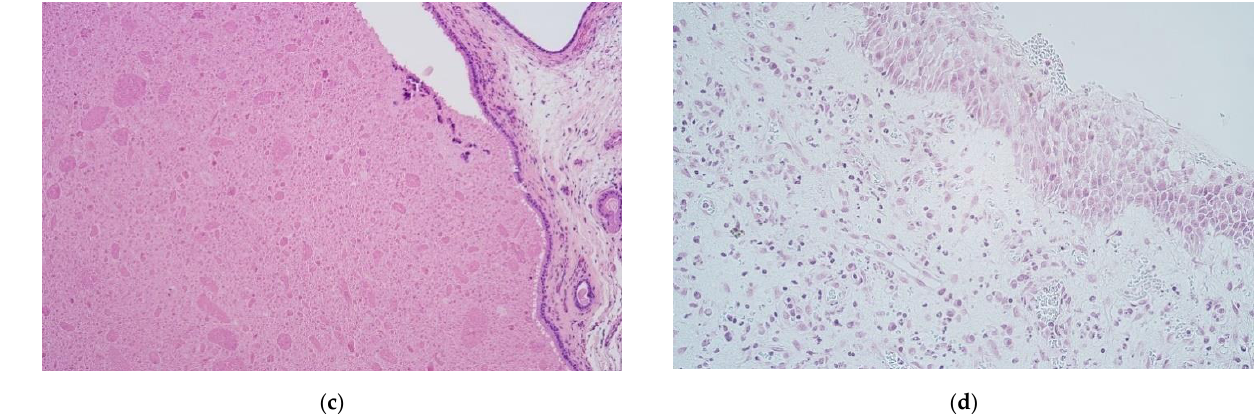
Figure 1 . ( a – d ) Micrographs of routinely stained nasal polyps ( a ) 50-year-old male with CRSwNP. Sample of a nasal polyp showing stratified squamous epithelium, thickening of the basal membrane and subepithelial connective tissue infiltration of neutrophils and eosinophils. HE, X 250; ( b ) 60-year-old female with CRSwNP.Rare glandular tissue with periglandular leukocyte infiltration within the subepithelial connective tissue. HE, X 250; ( c ) 78-year-old female with CRSwNP. A fragment of a large cyst formed within subepithelial glandular tissue. HE, X 100; ( d ) 30-year-old female with CRSwNP. Note epithelial basal cell proliferation and subepithelial connective tissue infiltration with inflammatory cells in polyp tissue. HE, X 250.